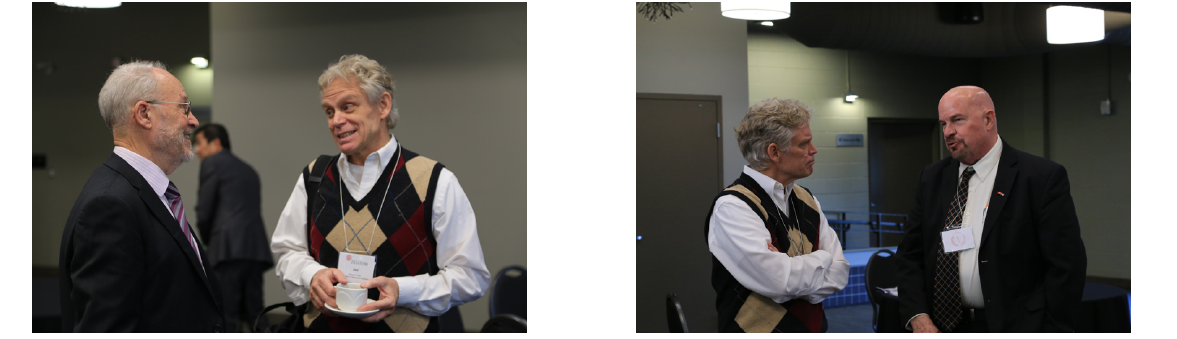
Figure 7: Advances in Predictive Analytics, 2017, University of Waterloo. The left-hand photo is a picture of an animated discus- sion with Greg Taylor and the right-hand panel shows a more serious discussion with Pat Brockett, two well-known scholars in actuarial